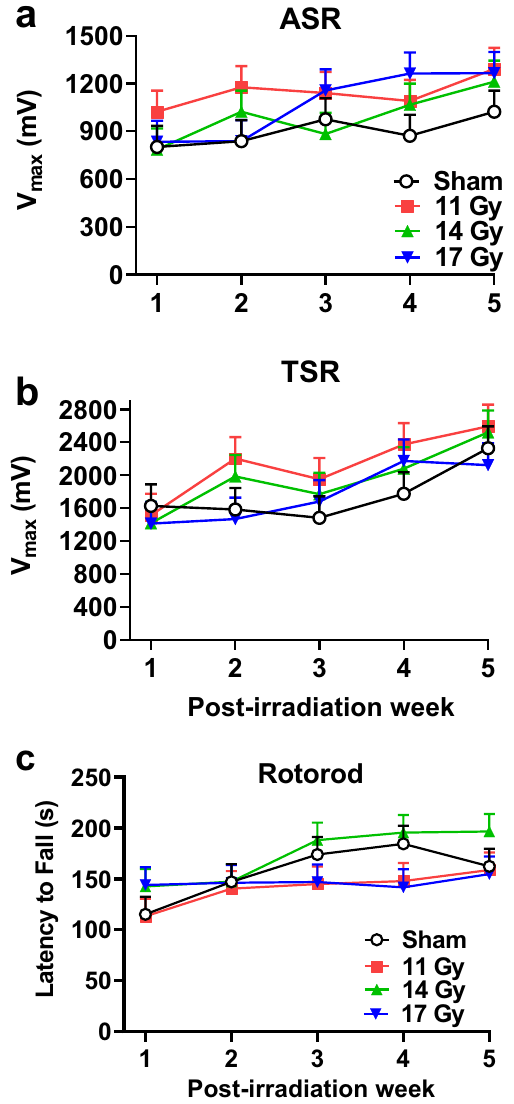
Figure 3. ( a ) ASR each week after proton exposure. ( b ) TSR each week after proton exposure. No differences were found for ASR or TSR. N = 10/group each week. ( c ) Weekly average latency to fall in the rotorod test. No differences were found. N = 10/group each week with the exception of week-4 when there were only 9 for the control, 11, and, 17 Gy